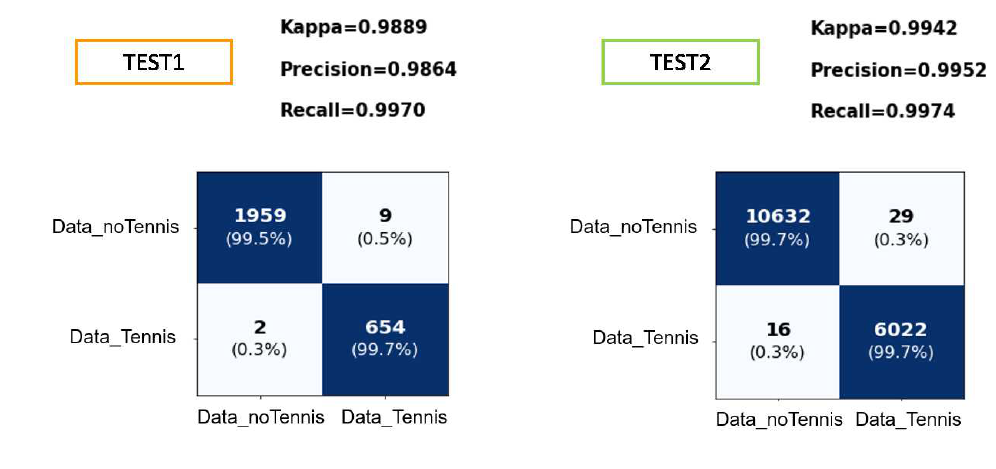
Figure 11. Confusion matrix for the tennis vs non-tennis activities. TEST1: Data test set separated from training set. TEST2: Test set regarding the player not introduced in training. Rows true label and columns the predicted label.